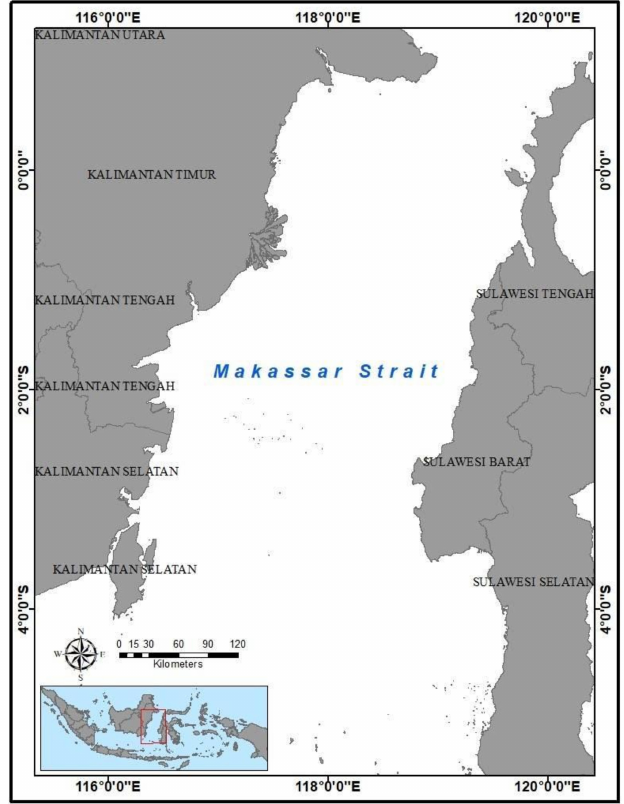
Figure 1. A Map showing the study area in the Makassar Strait. MS is flanked by Borneo Island in the west and Sulawesi on the east side (gray colors).